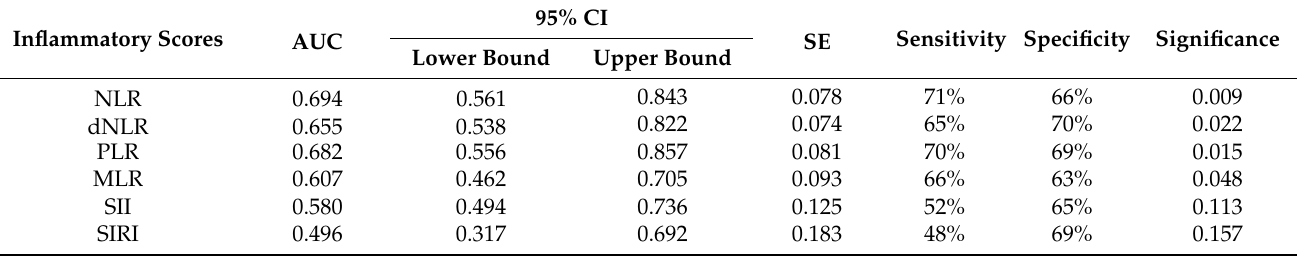
Table 3. ROC plot of the optimal inflammatory scores.